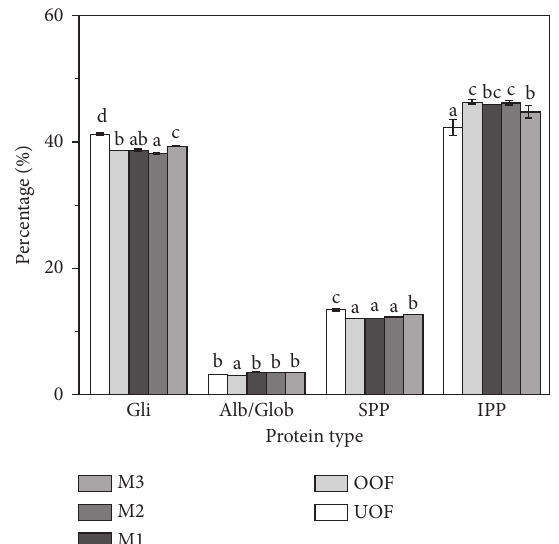
Figure 3: Percentages of protein fractions of wheat flour added with different ratios of overozonized wheat flour. For a specific protein fraction, means with the same letter were not significantly different ( α �